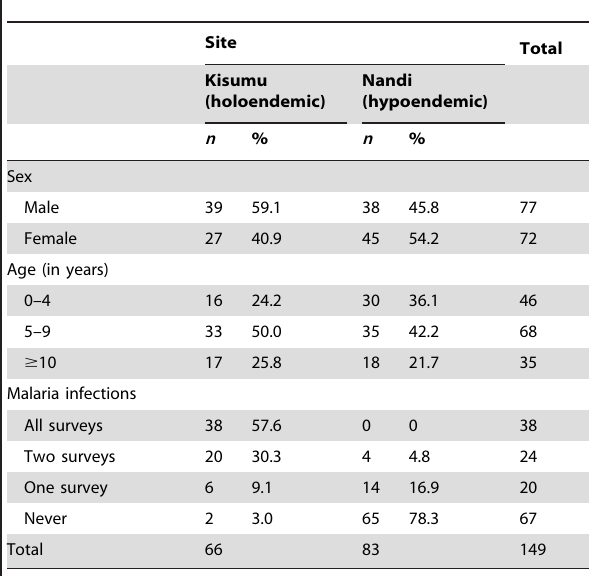
Table 1. Summary of participants in the Kisumu/Nandi cohort, Kenya 2002–2004 a